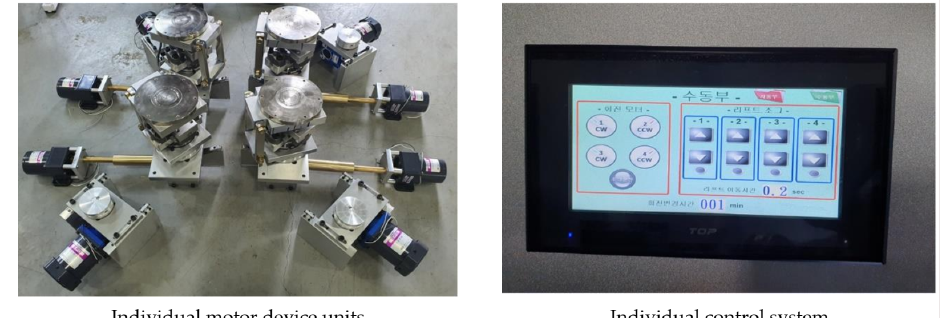
Figure 13. Control panel and the relevant motor